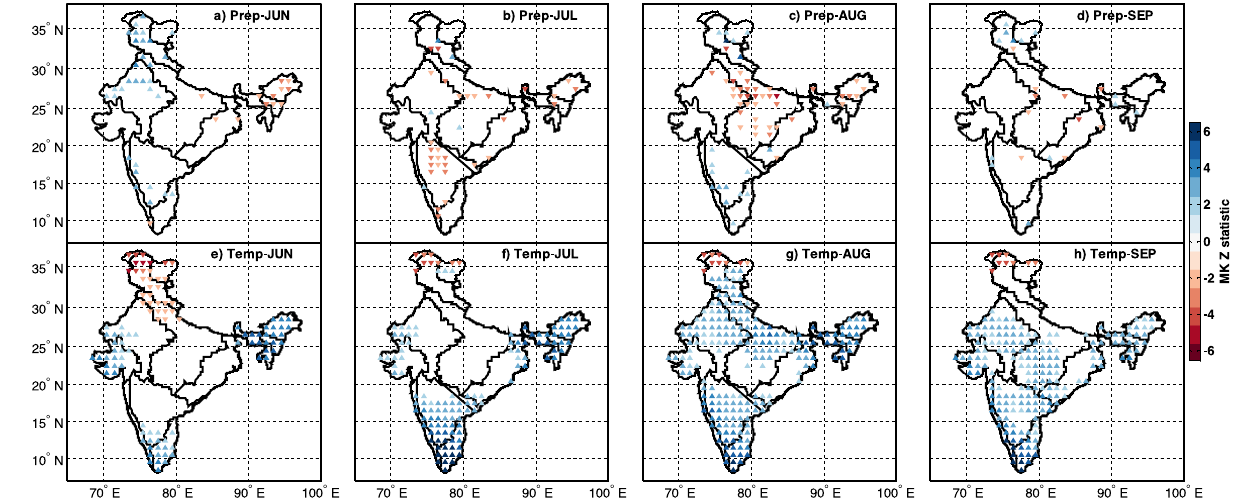
Figure 3. Geographical representation of trends in the monthly precipitation ( a–d ) and temperature ( e – h ) in Indian summer monsoon (June, July, August and September) of 1951–2019 across the homogenous regions of India. Statistical significance is conducted using the non-parametric Mann–Kendall (MK) test. Grid points with a 95% confidence level are only indicated with triangles. The Upper and Lower triangles indicate increasing and decreasing trend, respectively. Colorbar represents variation in the MK Z statistic. This figure is generated using Mapping Toolbox in MATLAB R 2020b (Version 9.9 https:// in. mathw orks. com/ produ cts/ mappi ng.